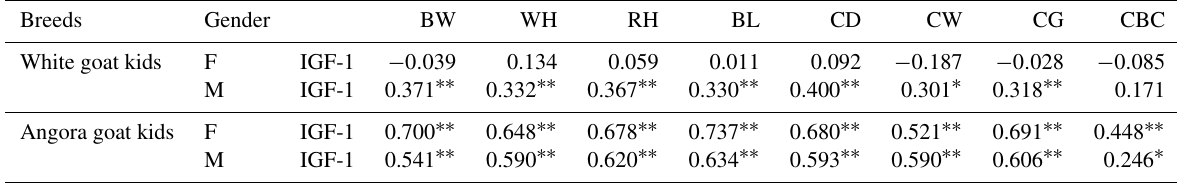
Table 6. Correlation coefficients between IGF-1 and some body trait measures in prepubertal goat kids. Breeds Gender BW WH RH BL CD CW CG CBC White goat kids F IGF-1 − 0 . 039 0.134 0.059 0.011 0.092 − 0 . 187 − 0 . 028 − 0 . 085 M IGF-1 0.371 ∗∗ 0.332 ∗∗ 0.367 ∗∗ 0.330 ∗∗ 0.400 ∗∗ 0.301 ∗ 0.318 ∗∗ 0.171 Angora goat kids F IGF-1 0.700 ∗∗ 0.648 ∗∗ 0.678 ∗∗ 0.737 ∗∗ 0.680 ∗∗ 0.521 ∗∗ 0.691 ∗∗ 0.448 ∗∗ M IGF-1 0.541 ∗∗ 0.590 ∗∗ 0.620 ∗∗ 0.634 ∗∗ 0.593 ∗∗ 0.590 ∗∗ 0.606 ∗∗ 0.246